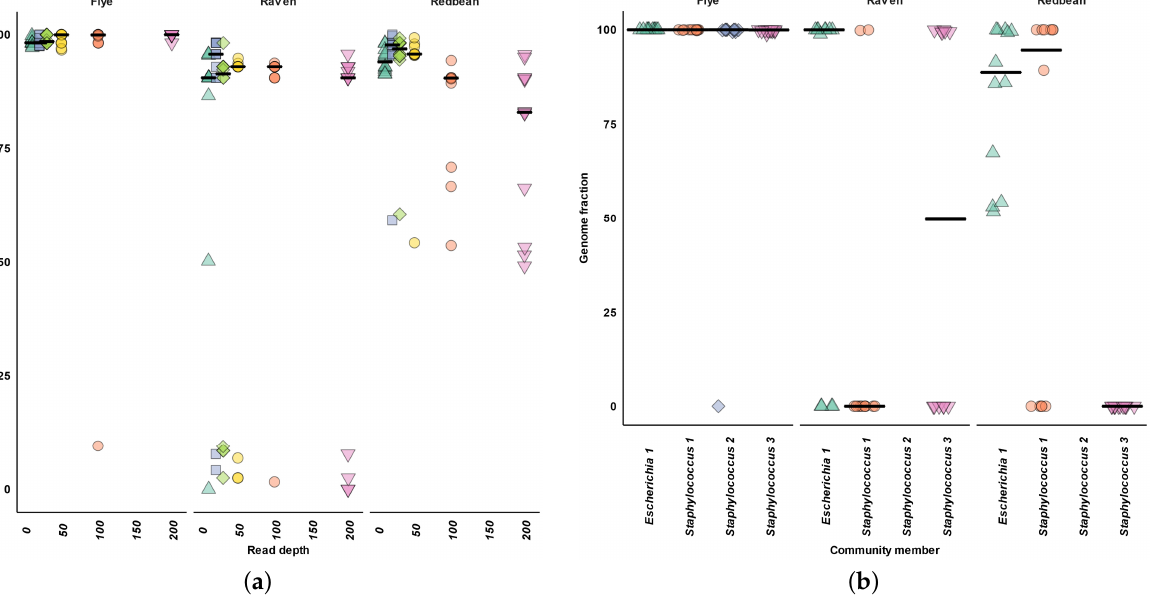
Figure 3. Plasmid completeness. ( a ) Plasmid metagenome fraction. ( b ) Plasmid genome fraction at 200 × read depth. The horizontal bars indicates the